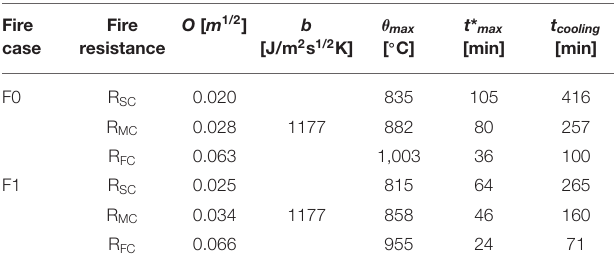
TABLE 2 | Design parameters of the cooling